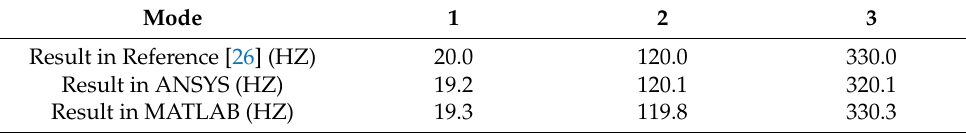
Table 3. The frequencies for an 80% covered passive constrained layer damping control (PCLD) beam. Mode Result in Reference [26]